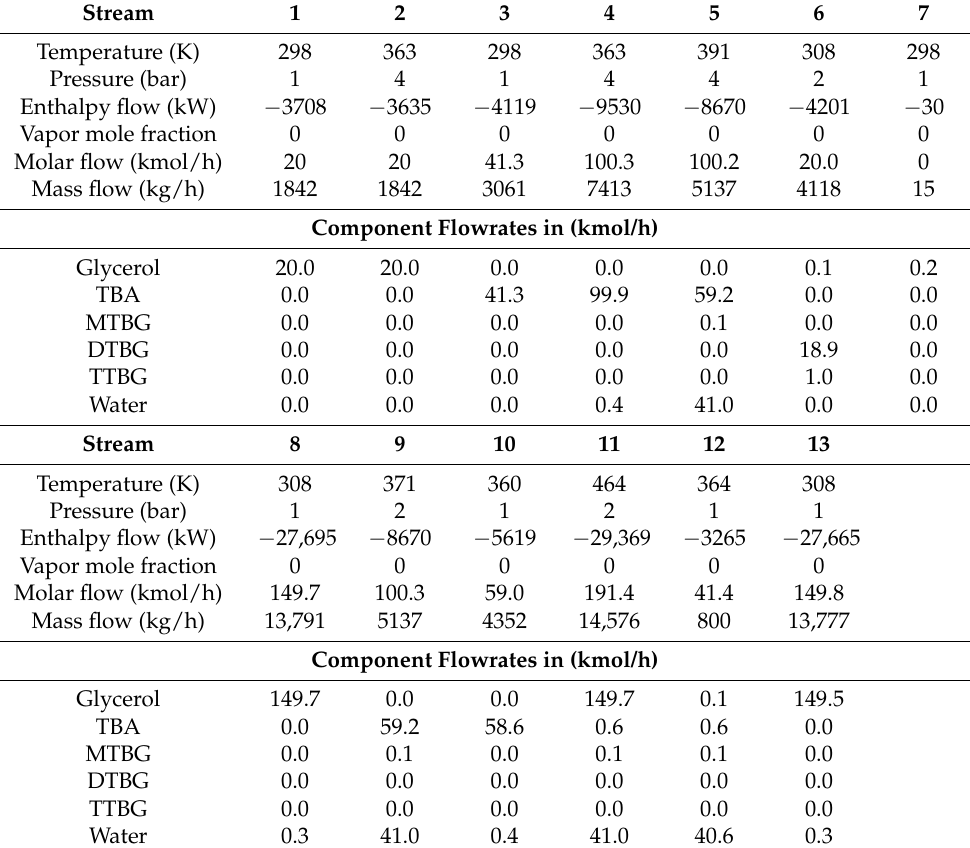
Table 5. Streams information of glycerol with TBA etherification